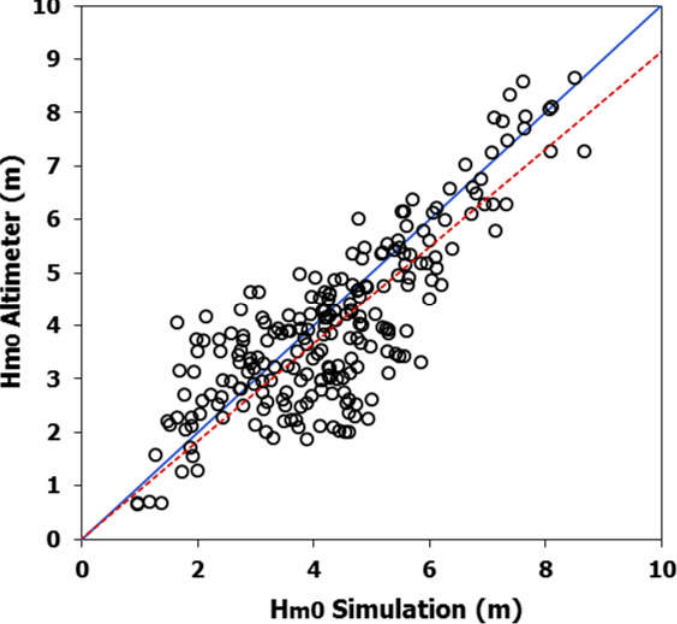
Figure 9. Satellite altimeter wave data against Mike 21 SW model results during tropical cyclone Kyarr (the blue line is x=y and redline is trendline)